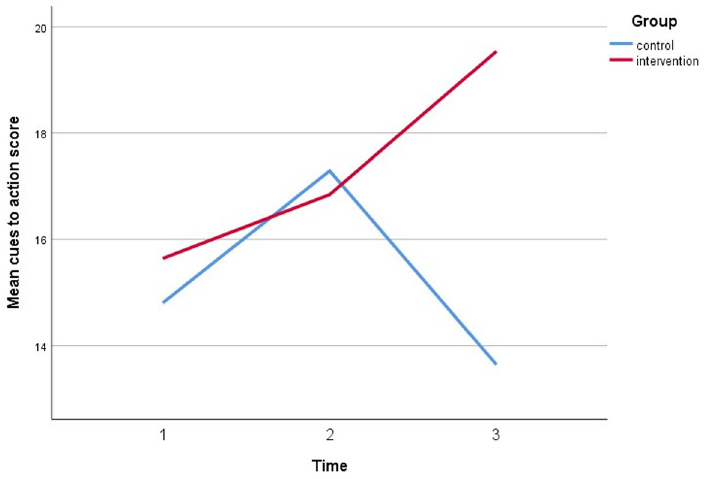
Fig 9. A plot of cues to action scores among respondents, showing an interaction between groups and